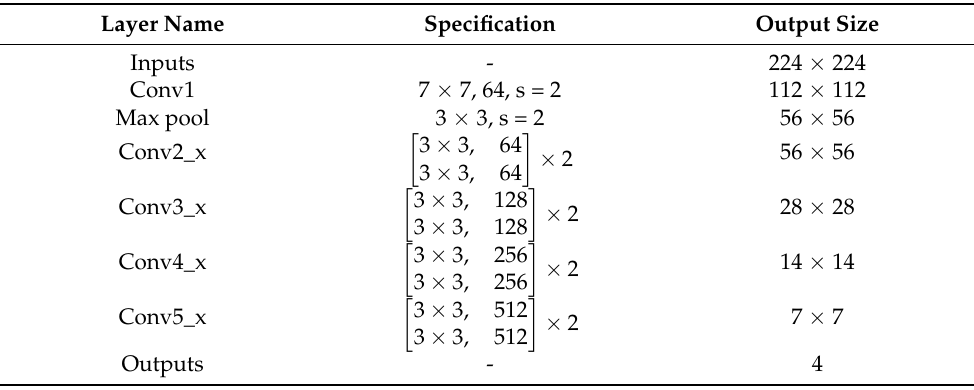
Table 3. The architecture of the DRN diagnostic